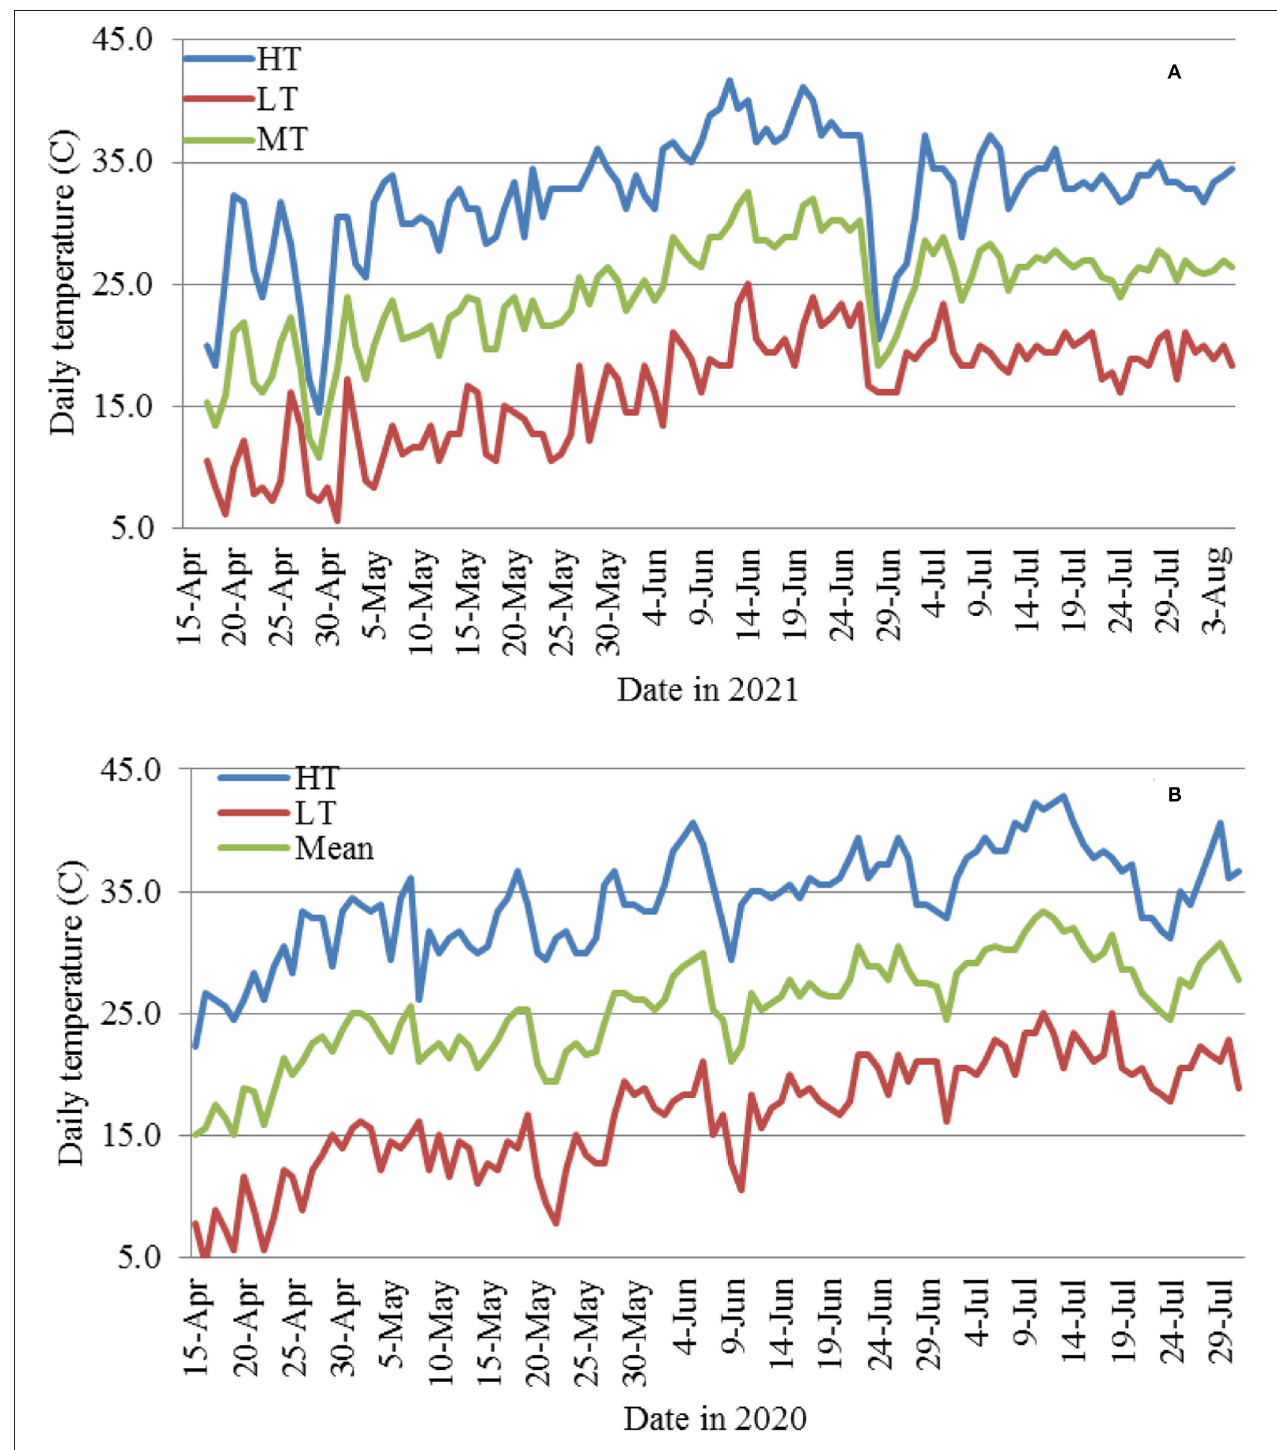
FIGURE 9 | Daily high (HT), low (LT), and mean (MT) temperatures from April 15 to late July or early Aug. in 2021 (A) and 2020 (B) .